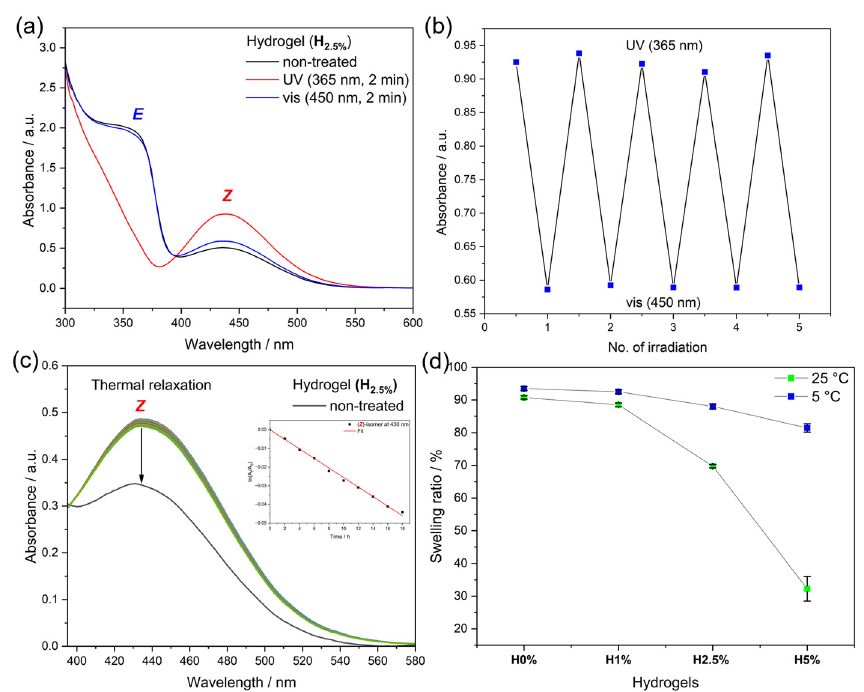
Figure 2. ( a ) UV-vis absorption spectra of dried Azo- co -NIPAAm hydrogel film ( H 2.5% , 0.1-mm- thickness) following synthesis and work-up: non-treated sample (black curve); ( Z ) isomer upon irradiation with UV light, λ = 365 nm for 2 min (red curve); ( E ) isomer converted by λ = 450 nm for 2 min (blue curve); ( b ) absorption intensity at λ max = 439 nm tracking the five cyclic measurements, reversibly switching between ( E ) and ( Z ); ( c ) thermal relaxation of hydrogel film ( H 2.5% , 0.7 mm in thickness) swollen in D 2 O, after irradiation with UV light, λ = 365 nm for 1 min (PSS), and recorded at intervals of 30 min for the ( Z ) isomer. Inset: first-order kinetics of H 2.5% film from the PSS (450 nm) at λ max = 430 nm in deionized H 2 O; ( d ) swelling ratio of the control H 0% , and the functional H 1%, H 2.5% , and H 5% hydrogels for four samples, S1 to S4, after equilibrating for 24 h at 25 °C and 5 °C, respec- tively.